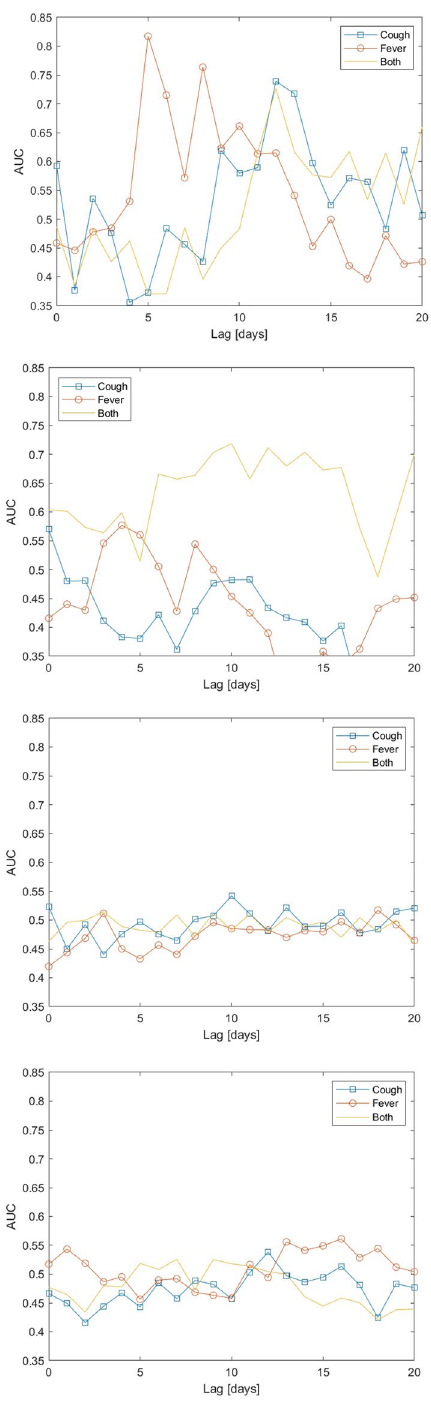
Figure 2. Area Under Curve (AUC) of the UTLA outlier measure for detecting unusually large rises in COVID-19 cases per UTLA, as a function of the lag between case counts and Bing data. The four figures refer to the four time periods: First wave (top) to fourth wave (bottom). Dates of the 4 periods are: (1) March 1st to May 31st. 2020, (2) June 1st to August 31st, 2020, (3) September 1st, 2020 to April 30th, 2021, and (4) May 1st, 2021 to December 13th, 2021. Curves are computed for all weeks and all UTLAs at each time